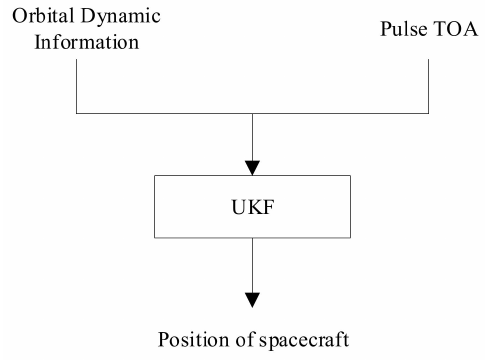
Figure 3. Composition of the navigation